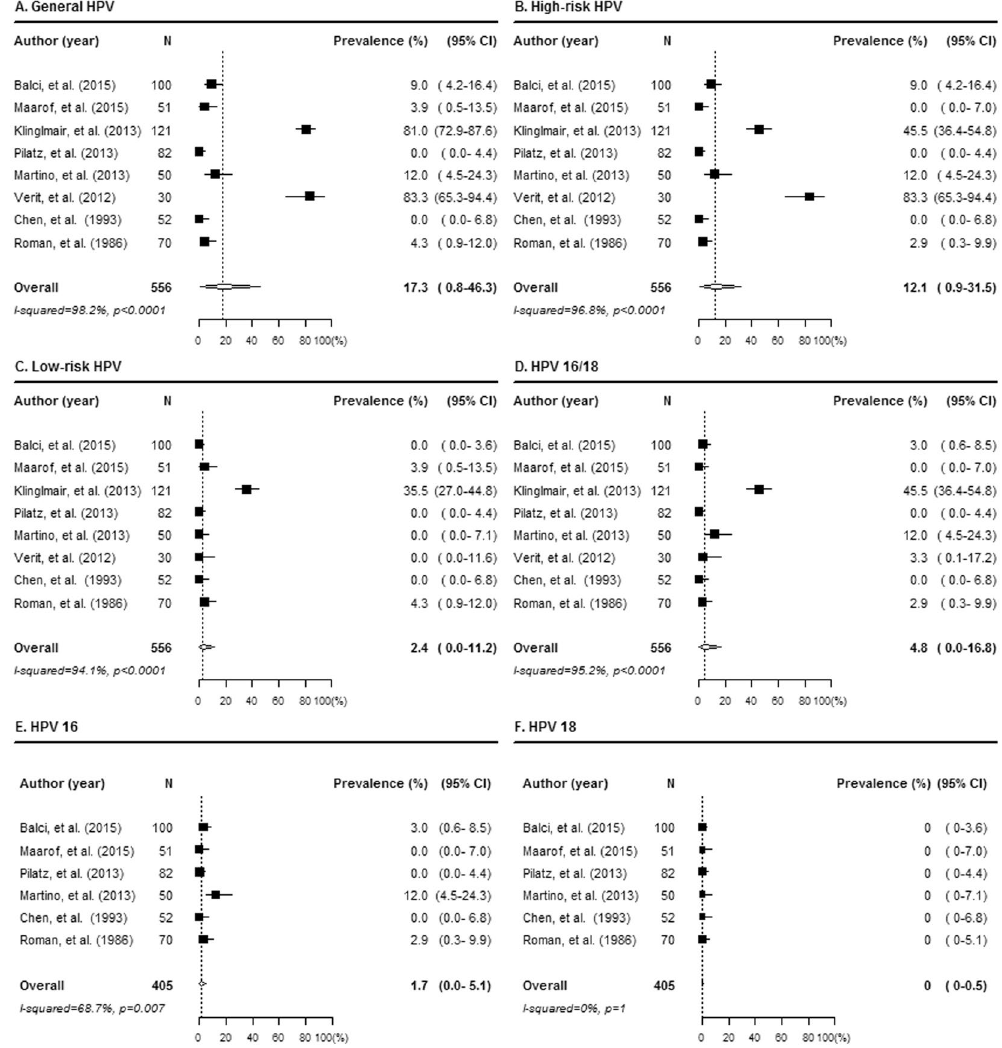
Figure 2. Prevalence of PCR-detected HPV infection. Forest plot diagram showing the pooled estimates for HPV prevalence for general HPV ( A ), high-risk HPV ( B ), low-risk HPV ( C ), HPV 16/18 ( D ), HPV 16 ( E ), and HPV 18 ( F ). The black square signifies the weighted mean of each estimate. All data provided are for continuous